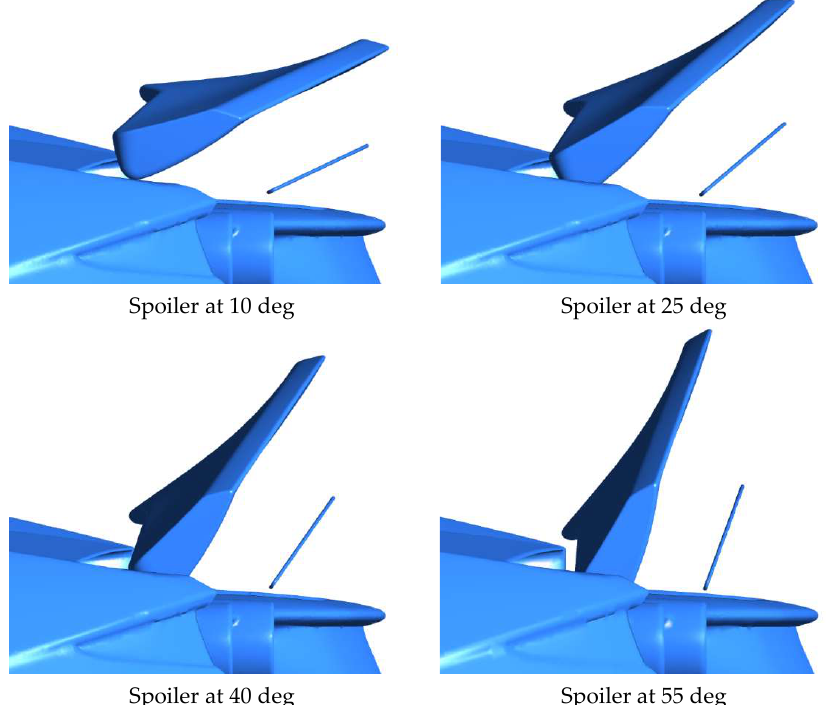
Figure 10. Relation between the spoiler and supporting plate inclination.